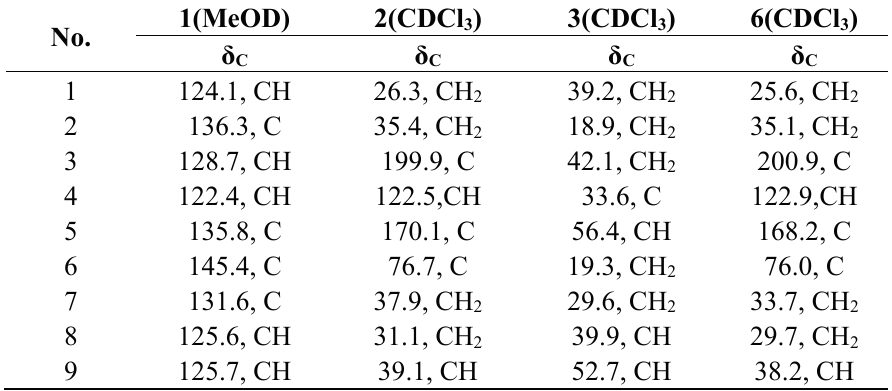
Table 2. The 13 C-NMR (150 MHz) spectroscopic data for compounds 1 – 3 and 6